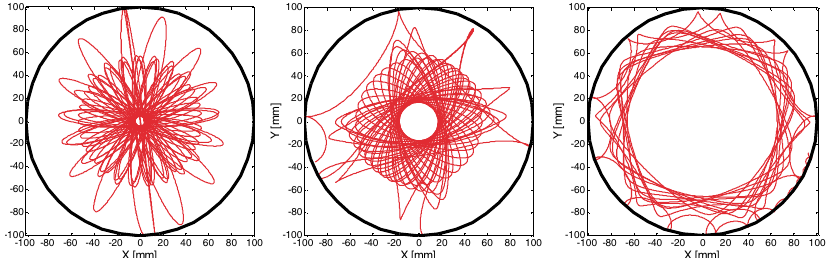
FIG. 11. (Color) Transverse electron trajectories in different solenoid fields (left panel) 0 G, (middle panel) 10 G, and (right panel) 30 G.